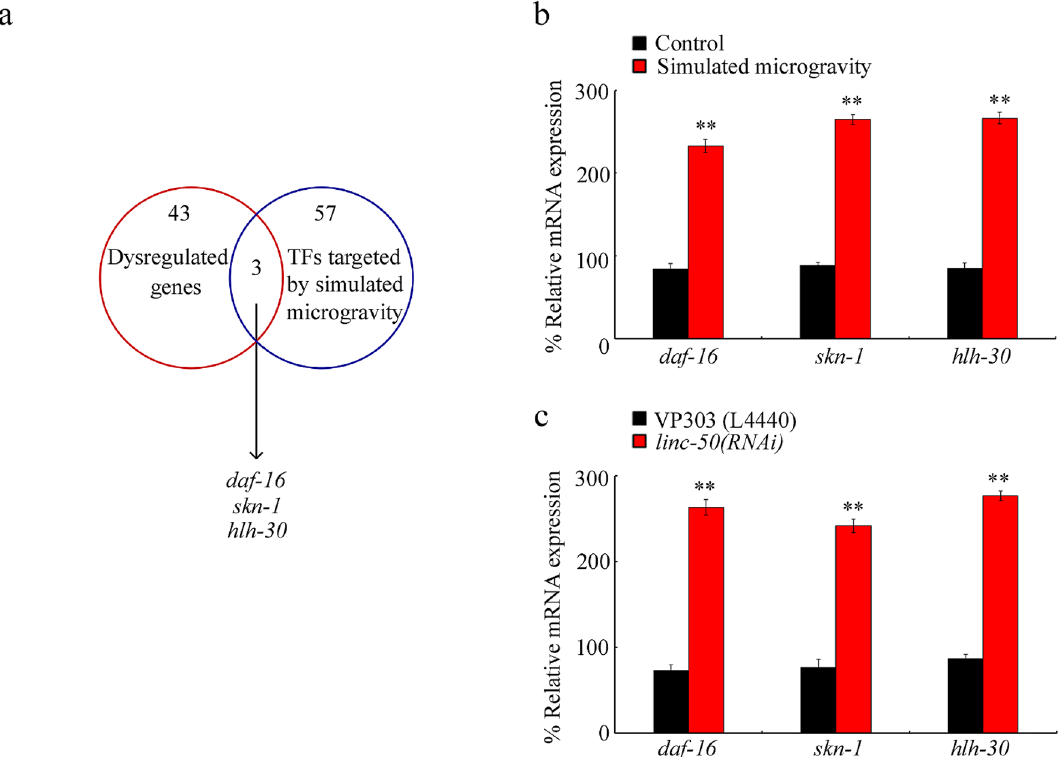
Figure 5. Screen of possible downstream transcriptional factors targeted by intestinal linc-50 in simulated microgravity treated nematodes. ( a ) DAF-16, SKN-1, and HLH-30 are candidate transcriptional factors targeted by linc-50 in simulated microgravity treated nematodes. TFs, transcriptional factors. ( b ) Effect of simulated microgravity on expressions of daf-16 , skn-1 , and hlh-30 . N = 3. Bars represent means ± SD. ** P < 0.01 vs control. ( c ) Effect of intestine-specific RNAi knockdown of linc-50 on expressions of daf-16 , skn-1 , and hlh-30 in simulated microgravity treated nematodes. N = 3. L4440, empty vector. Bars represent means ± SD. ** P < 0.01 vs VP303. Simulated microgravity treatment was performed in RCCS system at 30 rpm for 24